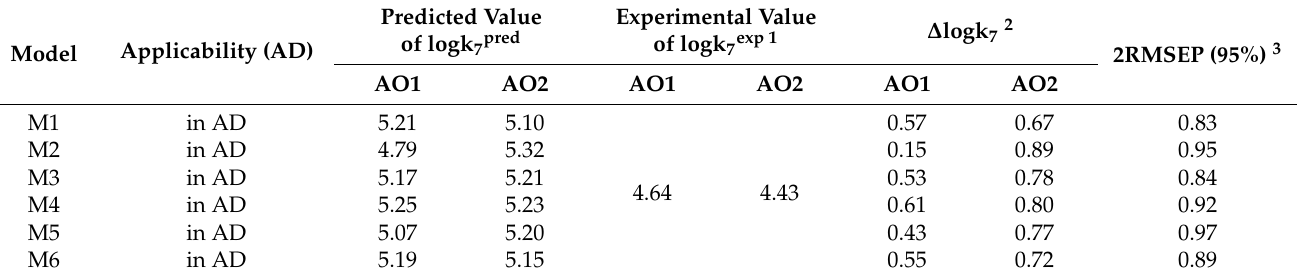
Table 4. Prediction of logk 7 for antioxidants AO1 and AO2, based on the M1–M6